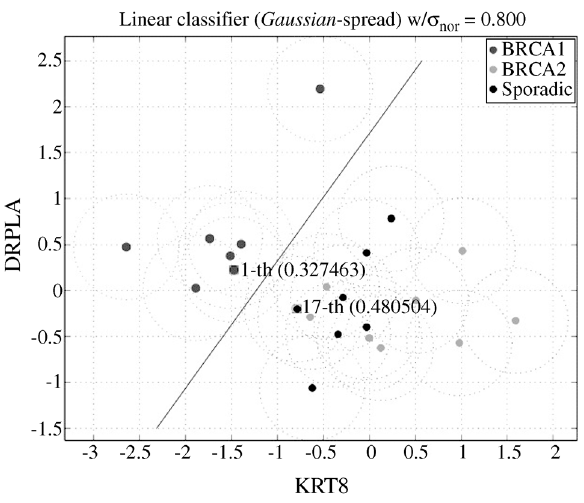
Algorithm for finding strong feature (gene)